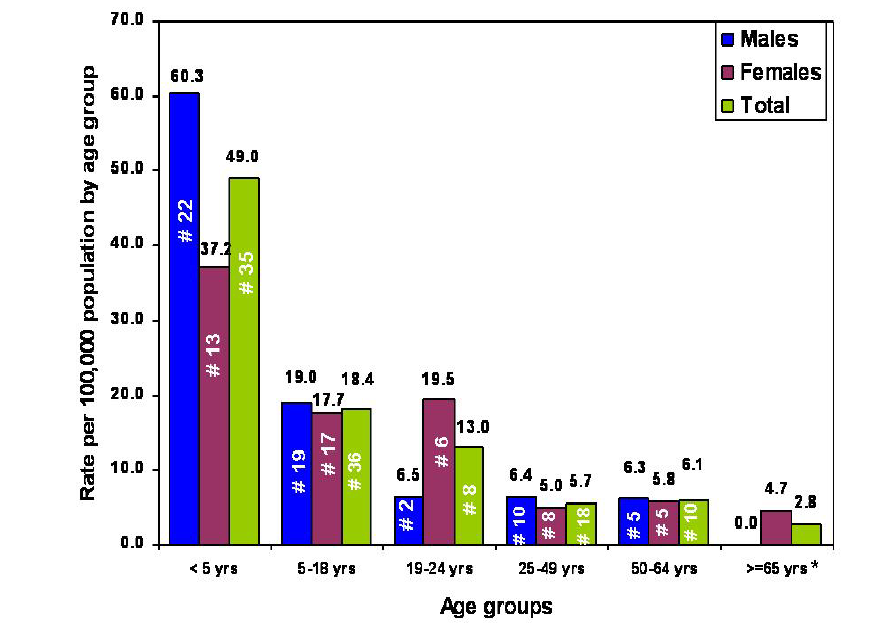
Figure 4. H1N1pdm associated Hospitalization Rate per 100,000 Population by age group in Milwaukee County, WI, from April 26 2009 to July 25 2009; Rate per 100,000 shown as numbers above bars; #, number of cases; * N for ≥ 65 years = 0, 3, 3 for Males, Females and Total (including gender not